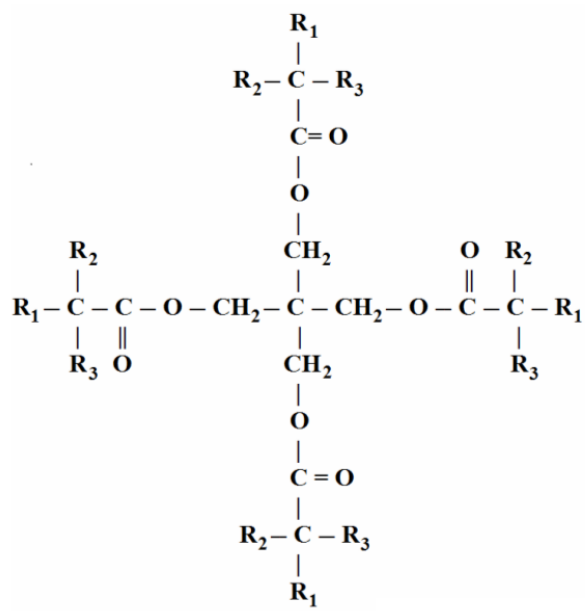
Figure 2. Simplified structural formula of pentaerythritol ester: R1, R2, R3—organic groups.